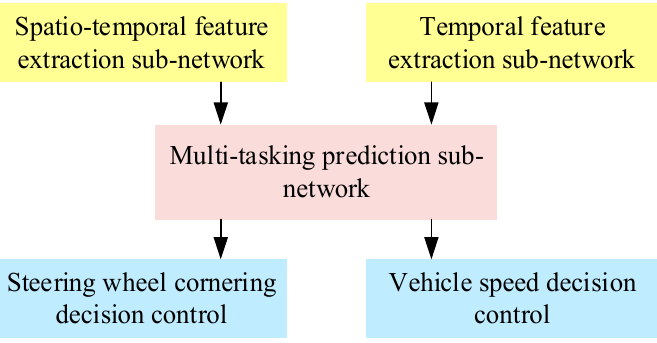
Figure 2. Multi-tasking prediction sub-network.